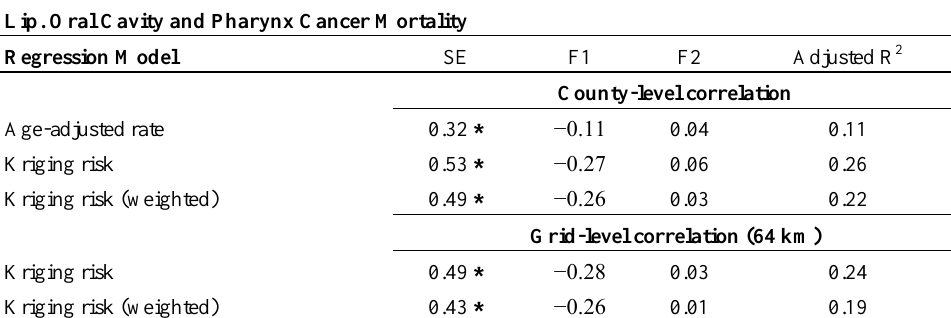
Table 5. Results of the correlation